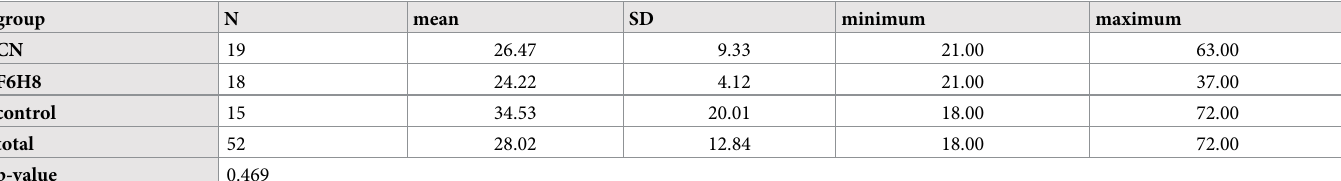
Table 4. Age distribution (long term analysis group).